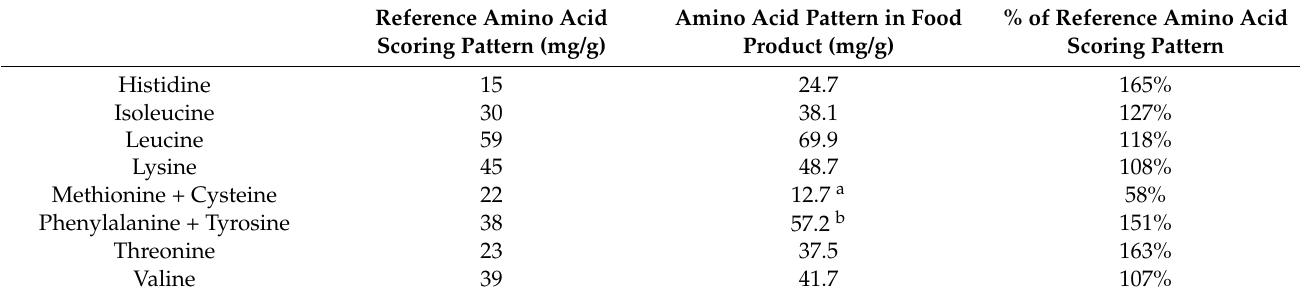
Table 3. Comparison of the actual amino acid pattern to a reference scoring pattern.